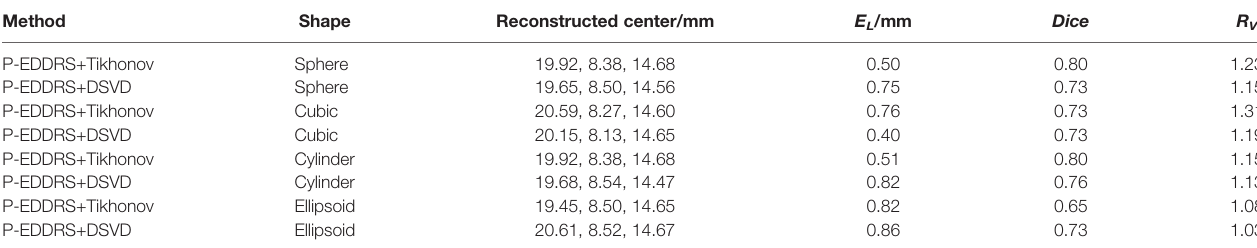
TABLE 5 | Quantitative evaluation results of P-EDDRS framework stability and robustness experiment II. Method